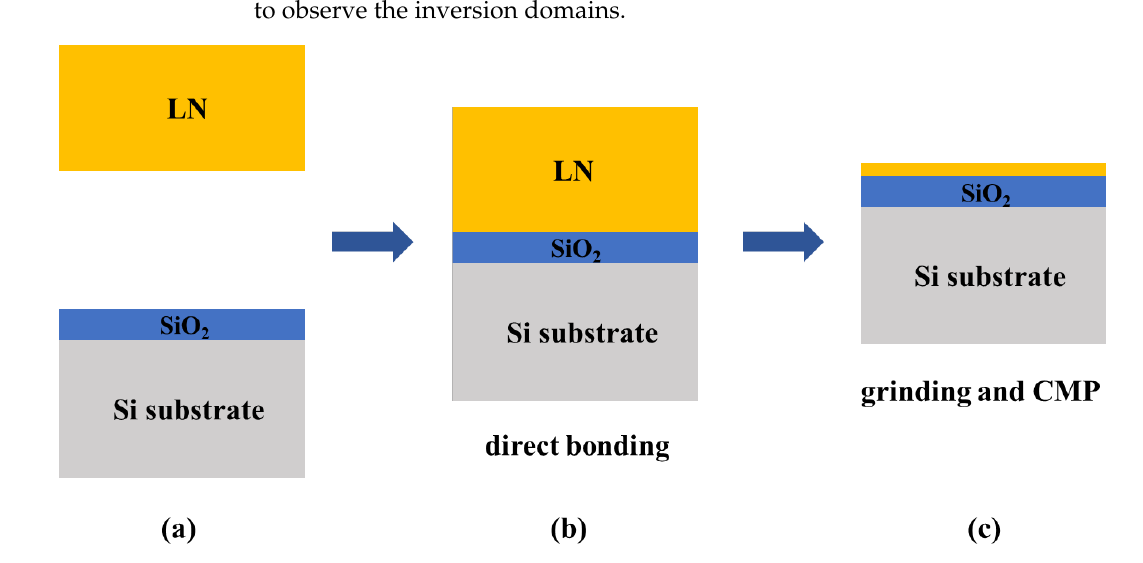
Figure 1. Fabrication process of grinded LNOI. ( a ) A layer of SiO 2 was grown on an Si substrate. ( b ) Si substrate and LN were directly bonded. ( c ) LN crystal was grinded and polished.